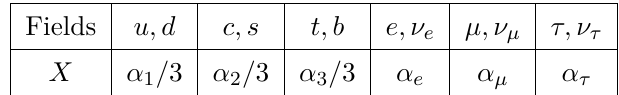
Table 1 . The (vector-like) X -charges of quarks and